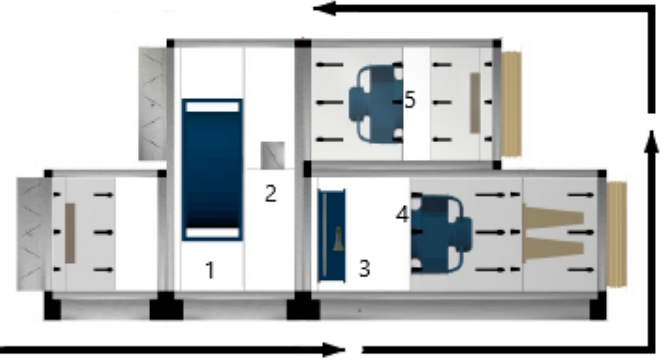
Figure 1. The schematic arrangement of components of AHU with the heat wheel. 1: Air-to-air rotary heat wheel; 2: Mixing box; 3: Direct expansion cooling / heating (DX) coil; 4: Supply fan; 5: Exhaust fan.